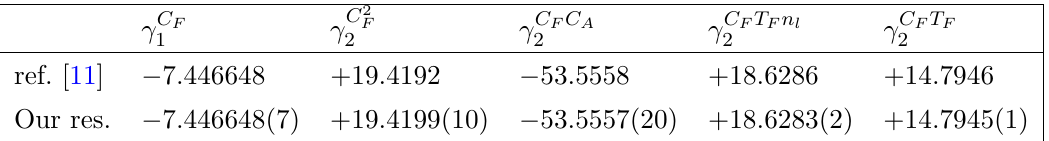
Table 2. The results for the NLO and NNLO coe(cid:14)cients of the total decay width split into independent colour structures. The renormalisation scale is set to (cid:22) R = M H . The uncertainties quoted for our results correspond to errors from numerical integration. We note that the results do not include the y b y t